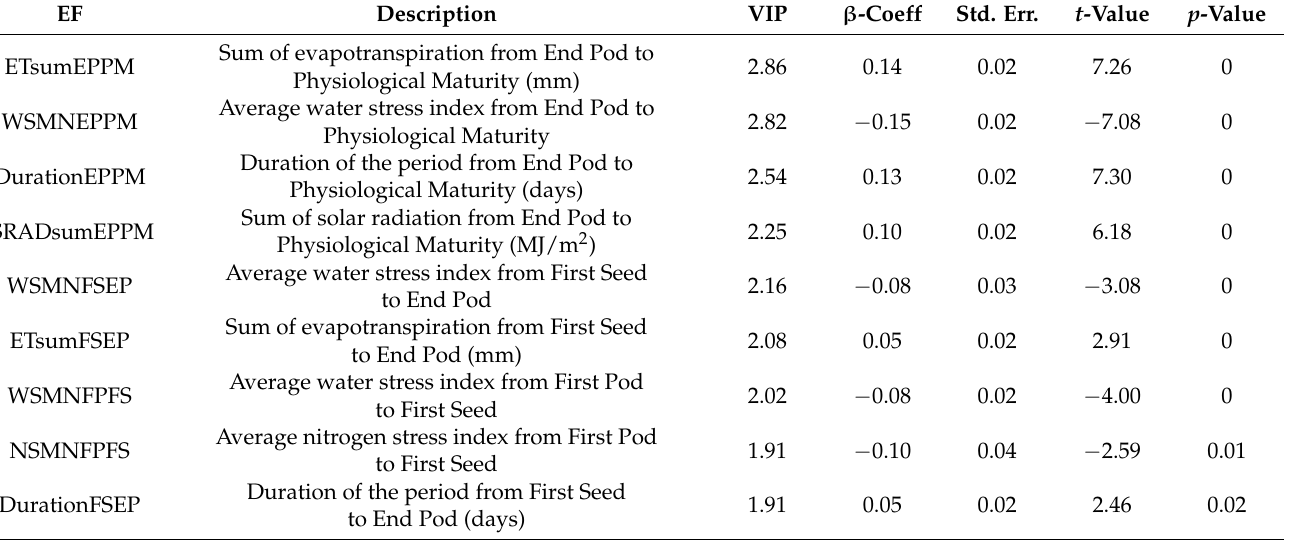
Table 2. Eco-climatic factors with a VIP > 1.9 sorted by descending VIP attributed after PLS analysis. PLS analysis was performed on 112 trials conducted from 2017 to 2021, associated with 126 eco- climatic factors (i.e., environmental factors calculated between two developmental stages). The statistical model estimated that the five-components option was the optimal solution based on minimising RMSE. β -regression coefficients indicate whether the considered factor had a positive or negative effect on observed